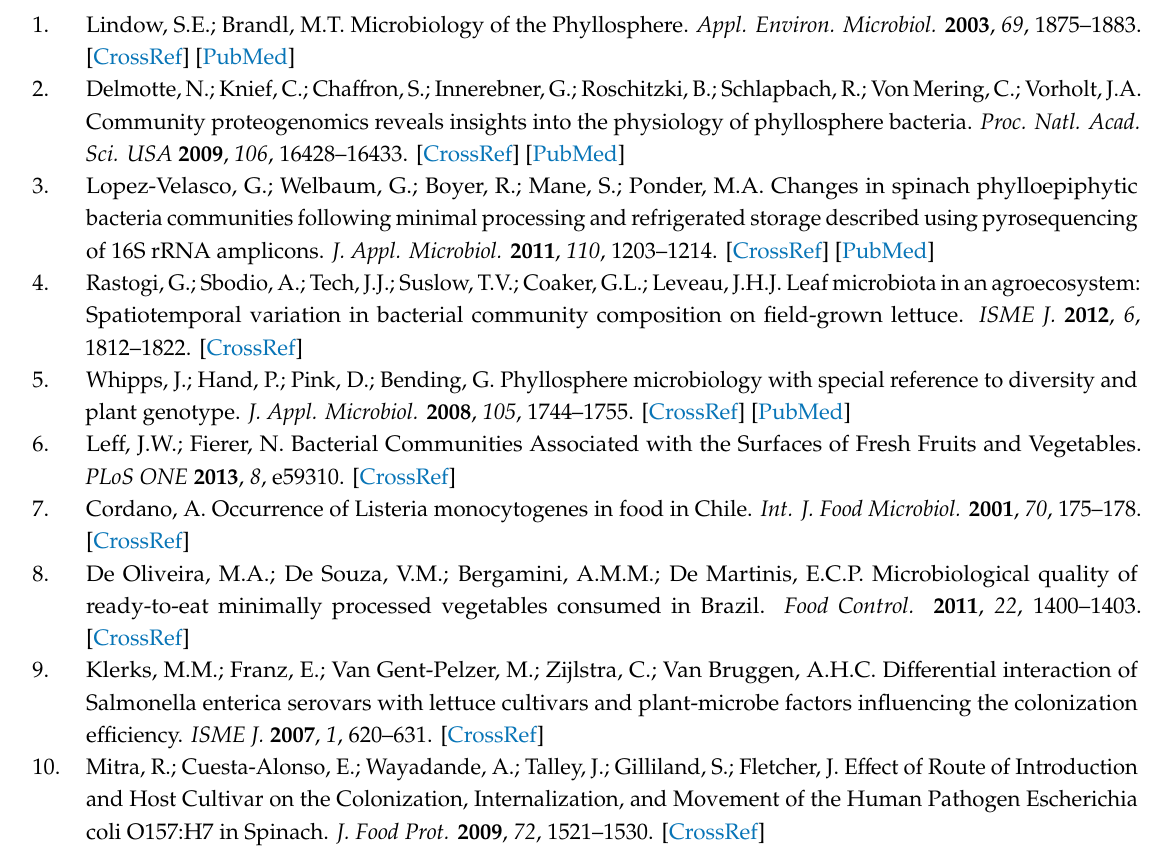
Figure S1. Relative Abundance ratio of bacterial taxonomy level order for sanitization wash types and sampling days.; Figure S2. Visualization of Shannon and Inverse–Simpson diversity (alpha-diversity) and Chao and ACE richness metrics of all samples.; Table S1. Total abundances and percentage abundances of most abundant